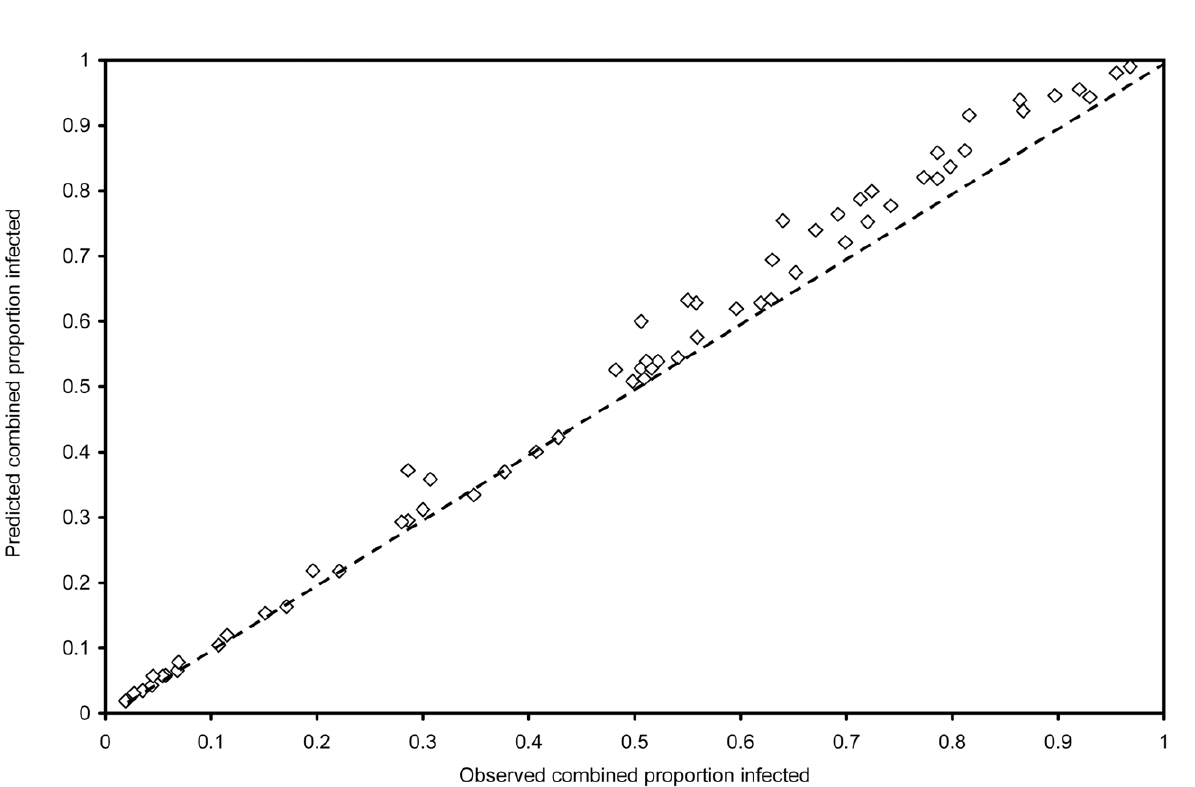
Figure 2. A scatter plot of the observed combined proportion infected with any intestinal nematode worms and the predicted combined prevalence.